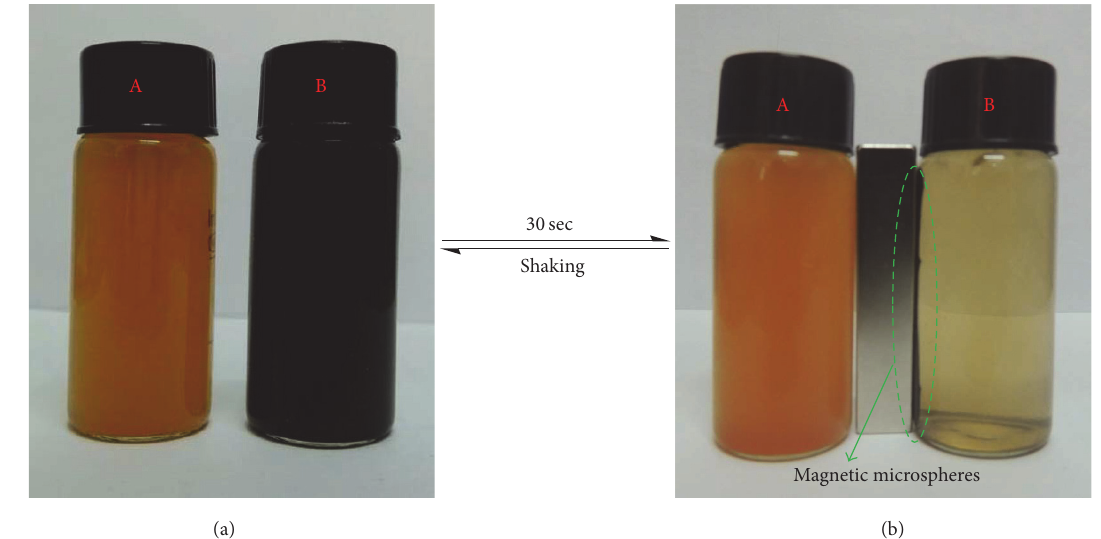
Figure 7: The optical images of the (vial A) Fe(OH) 3 @PMMA microspheres and (vial B) magnetic microspheres dispersed in water: (a) before being attracted by a magnet and (b) being attracted by a